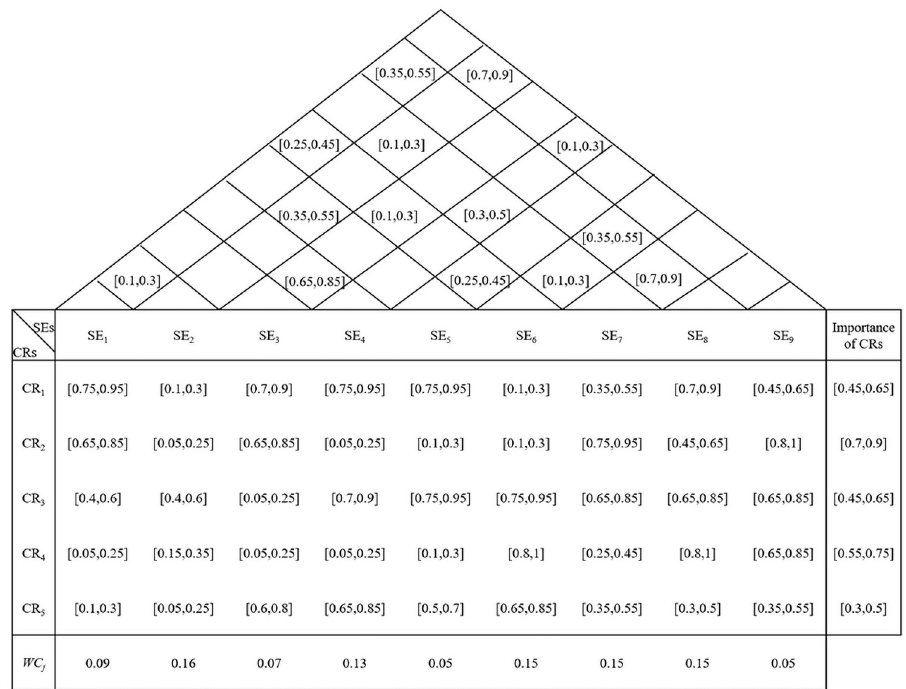
Fig 4. Final HOQ for the medical supplier selection problem.